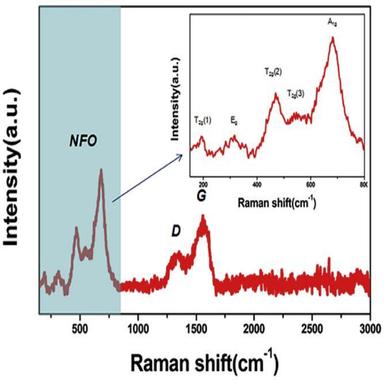
Raman spectrum of NFO/GNSs-10.